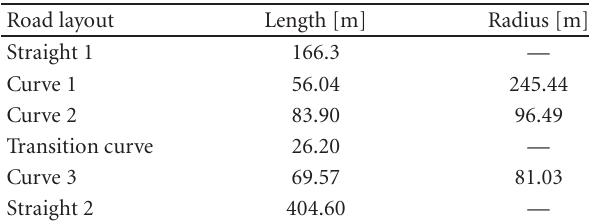
Figure 4: Road layout and geometrical characteristics. Table 2: Geometrical characteristics of road layout